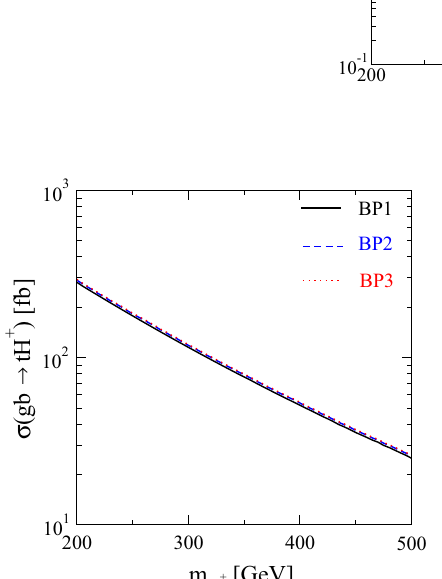
Fig. 10 Cross section of the gluon–bottom fusion process of H ± as a function of the extra neutral Higgs boson mass at BP2 and BP3 with tan β =